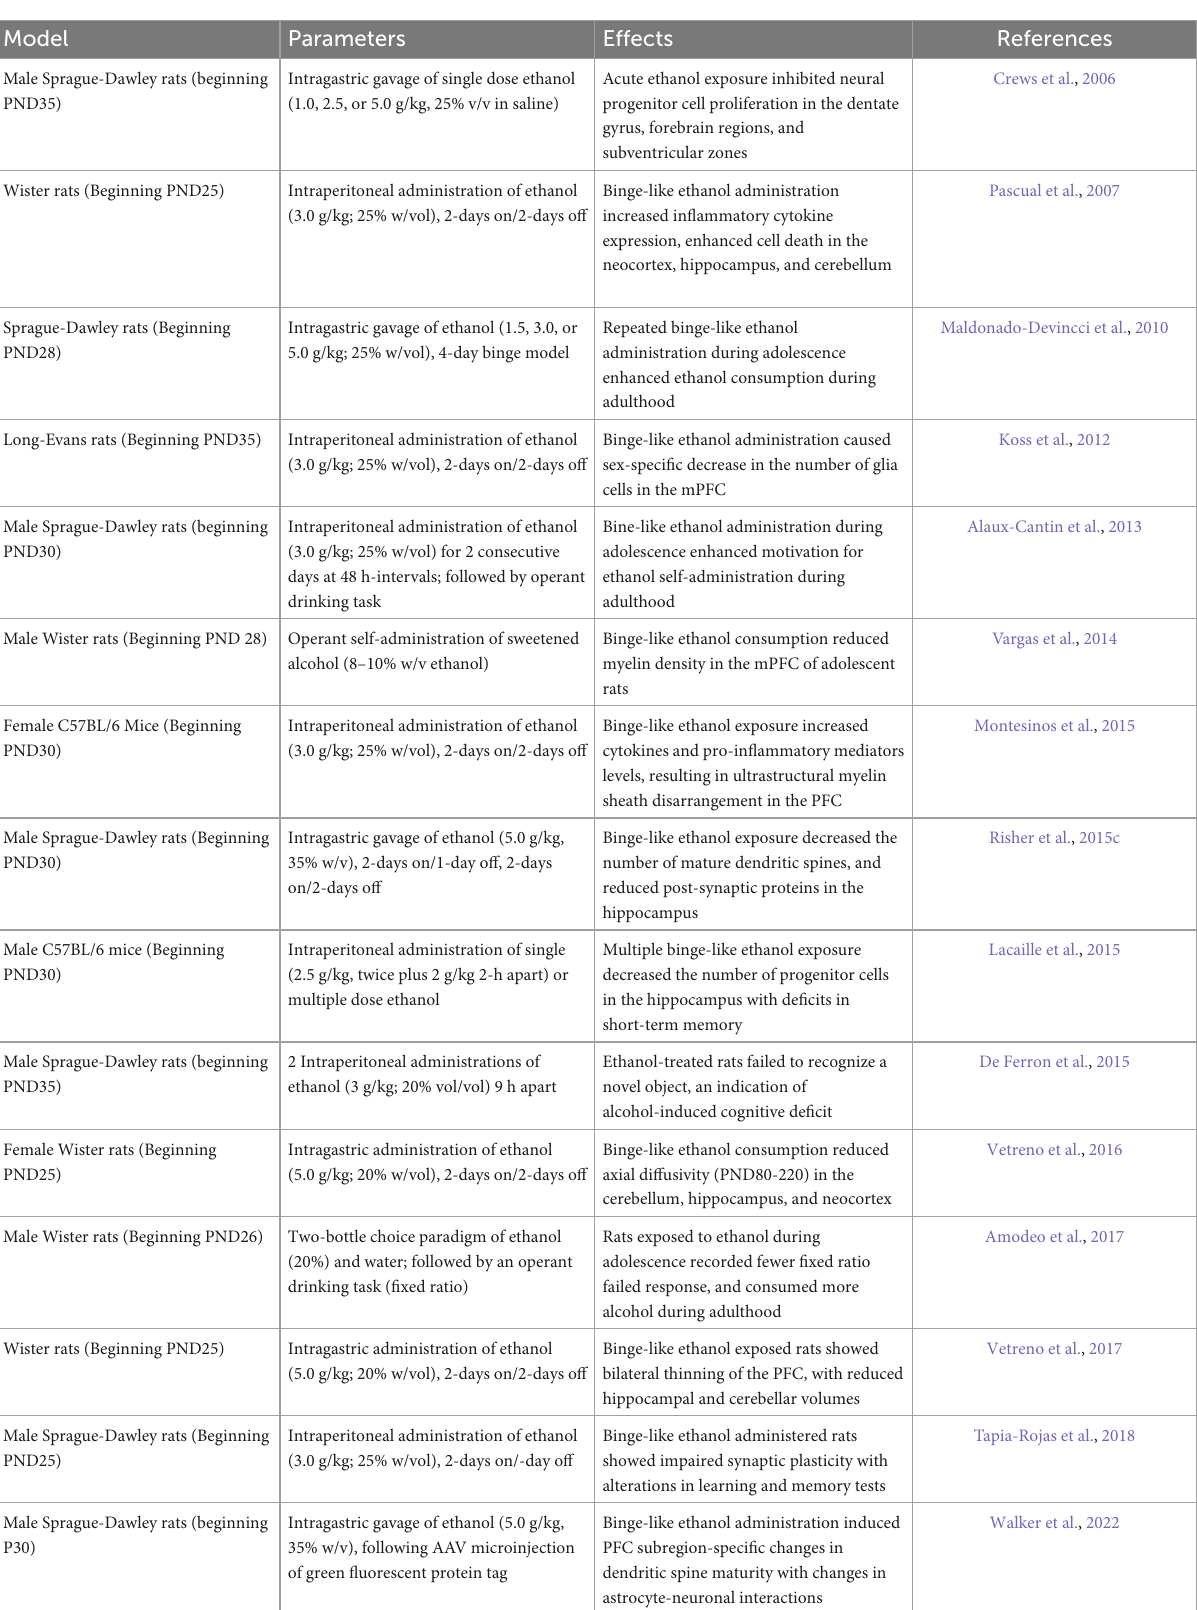
TABLE 2 Summary of studies exploring the effect of adolescent binge-like ethanol intake in rodent models.